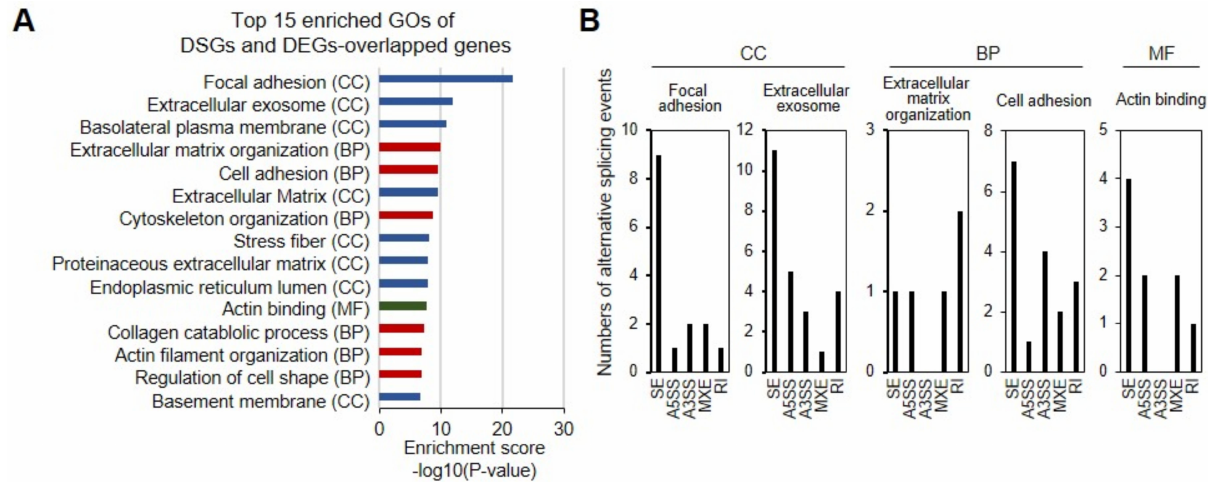
Figure 4. Comparative GO analysis of DEGs with AS events between iMSCs and UCB-MSCs. ( A ) The top 15 GO terms for DEGs with AS events. The bar chart shows 15 GO terms significantly enriched in iMSCs. The x-axis indicates the enrichment scores [-log10 ( p value), p -value cut-off of 0.05] for each GO term. The y-axis shows the detailed classification of each GO term. ( B ) The number of the five types of AS events for each indicated GO